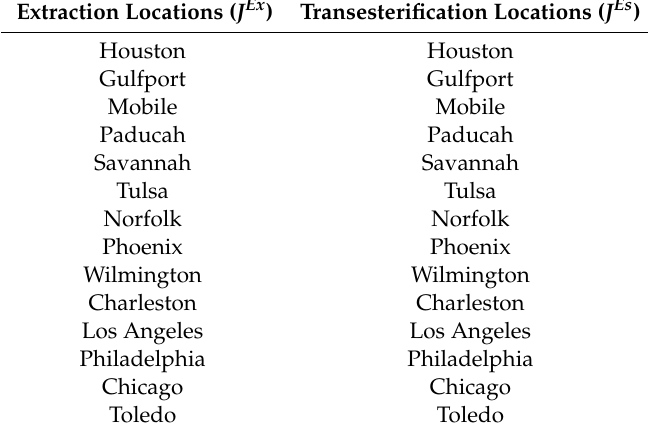
Table 4. Extraction and transesterification locations for the United States case of the algal biomass to biodiesel problem.